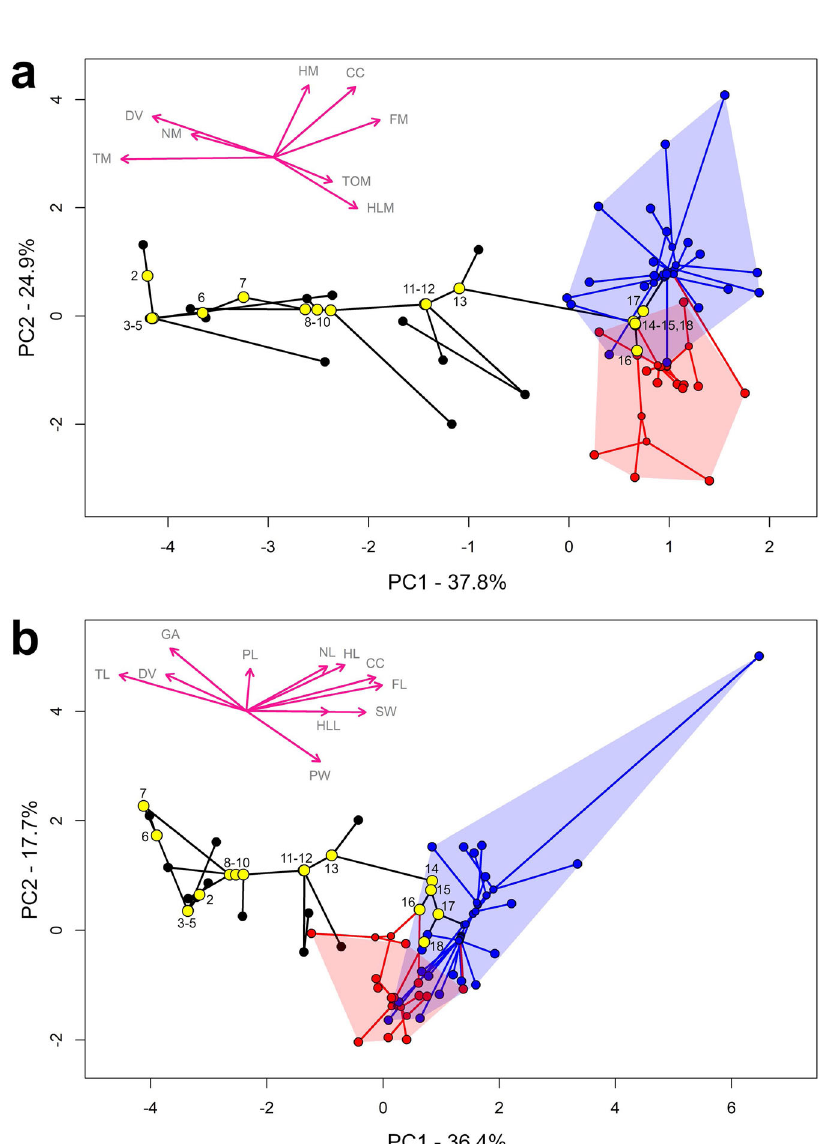
Palaeognathae, 17. Neognathae, 18. Galloanserae. Green data points and lines represent extant non-avian sauropsids, black data points and linesare extinctnon- avian sauropsids, red data points and lines represent hindlimb dominated birds, and blue data points and lines are forelimb dominated birds. Silhouettes of Microraptor , Silhouettes of Microraptor , Tyrannosaurus and the ornithomimid by Matthew Dempsey, used with permission and without modi fi cation. Silhouettes of Coelophysis (CC BY 3.0; https://creativecommons.org/licenses/by/3.0/) and Her- rerasaurus (CC BY 3.0; https://creativecommons.org/licenses/by/3.0/) by Scott Hartman sourced without modi fi cation from www.phylopic.org. Source data are provided as a Source Data fi le.